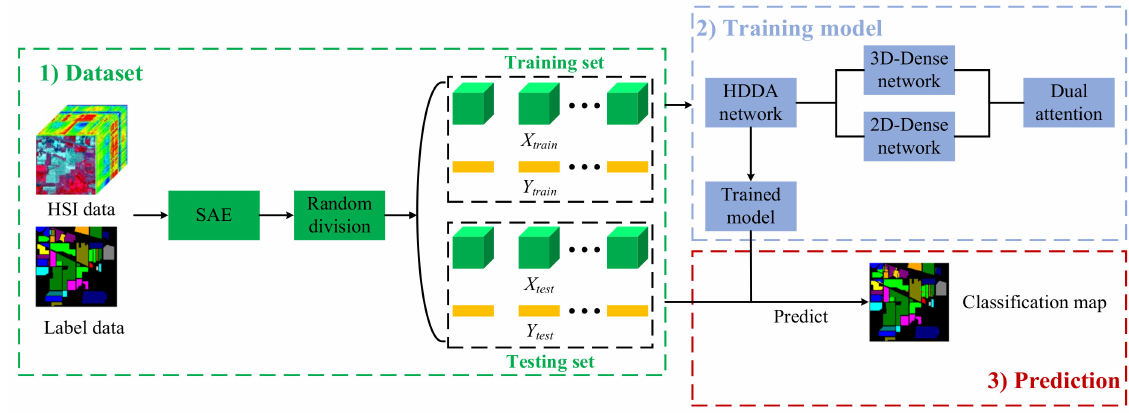
Figure 7. The working procedure of our proposed HSI classification framework.